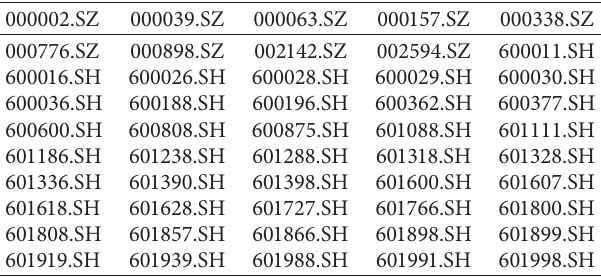
Table 1: The stock exchange codes of the selected